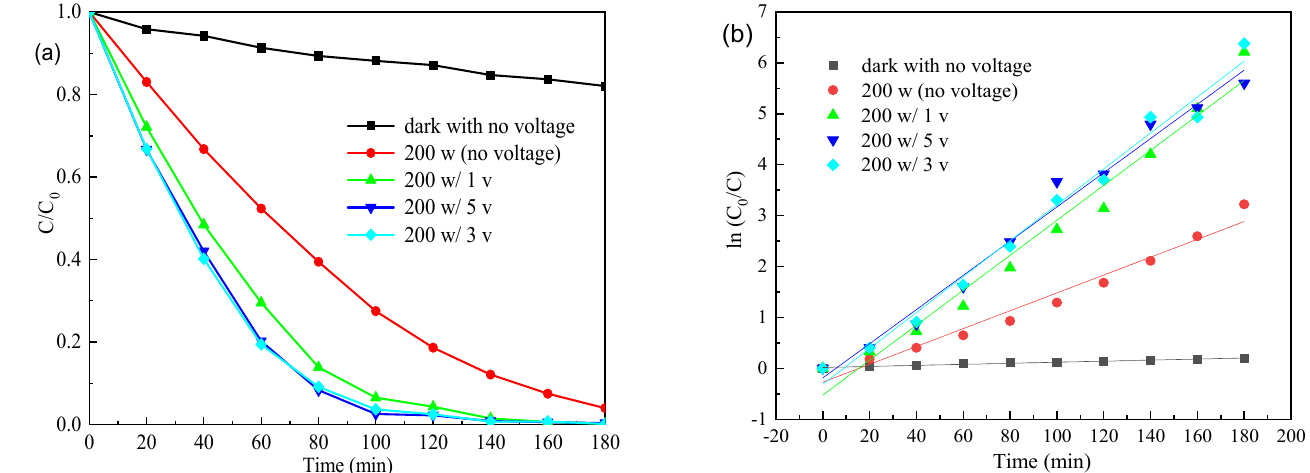
Figure 7. ( a ) Photo (electro) degradation of MB, ( b ) linear transform ln (C 0 /C) of the kinetic curves of MB by 25% Fw-Co(OH) 2 /g-C 3 N 4 at different voltages.